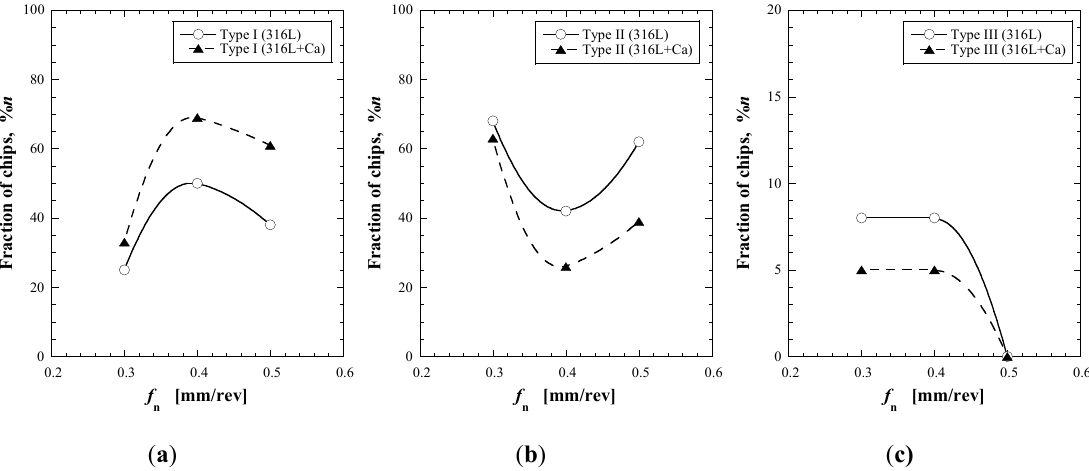
Figure 5. Chip weight distributions for Type I ( a ), Type II ( b ) and Type III ( c ) chips obtained at an a p value of 3 mm and a cutting speed of 180 m/min.